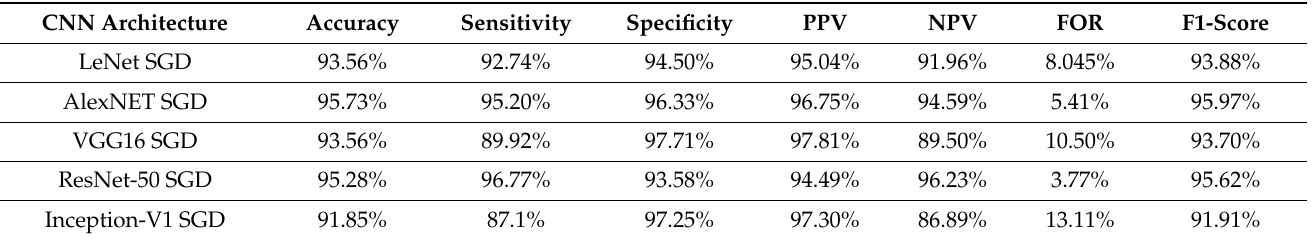
Table 13. Validation statistical analysis of five CNN architectures with the SGD optimizer confusion matrix (5-fold cross-validation).